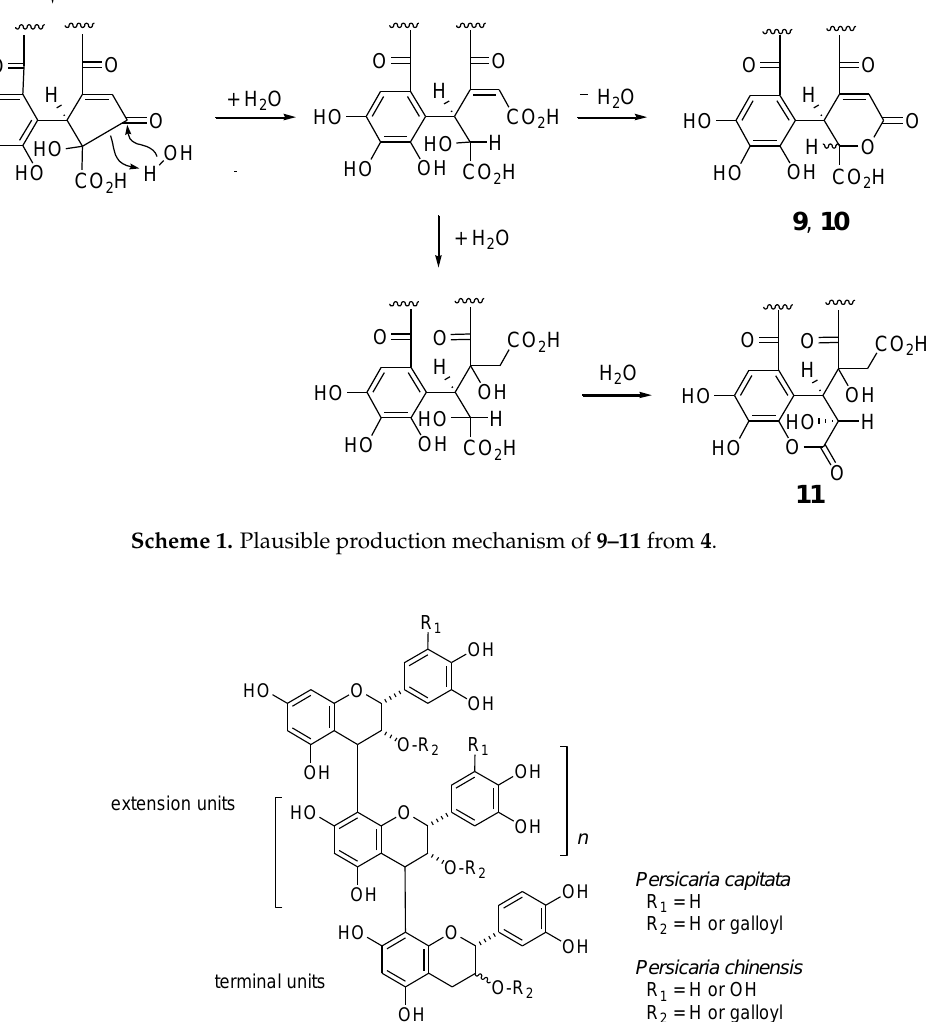
Figure 6. Structures of oligomeric proanthocyanidins of Persicaria capitata and P. chinensis suggested by thiol degradation.